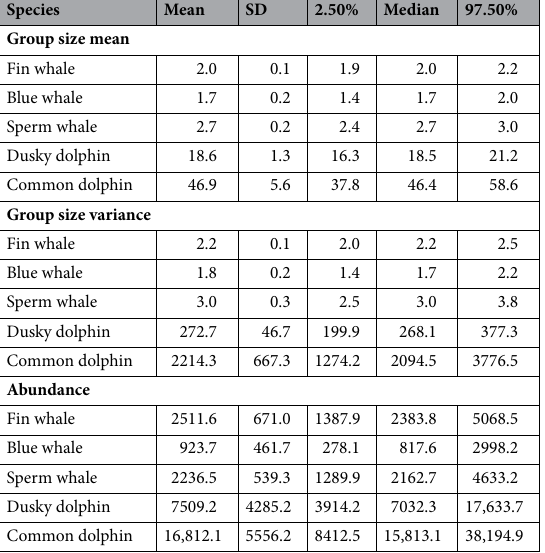
Table 3. Mean, standard deviation, median and credible intervals for group size parameters and abundance